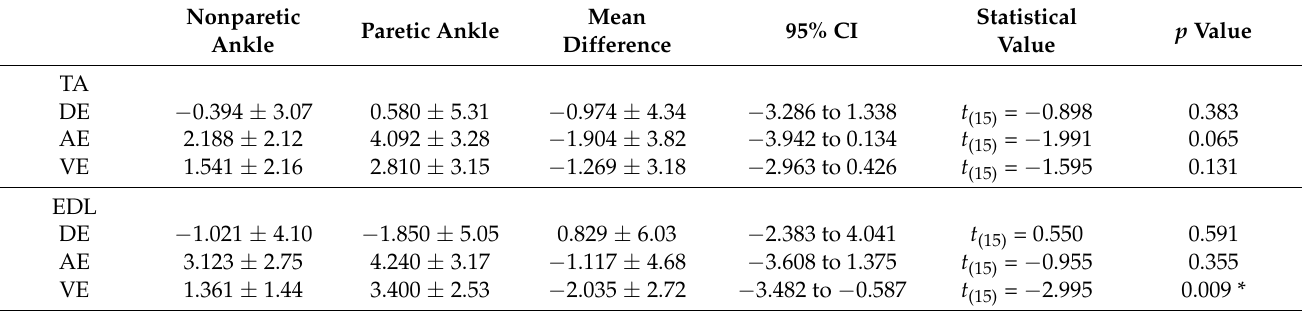
Table 3. Differences in muscle perception performances between the paretic and nonparetic ankles in stroke patients ( n =